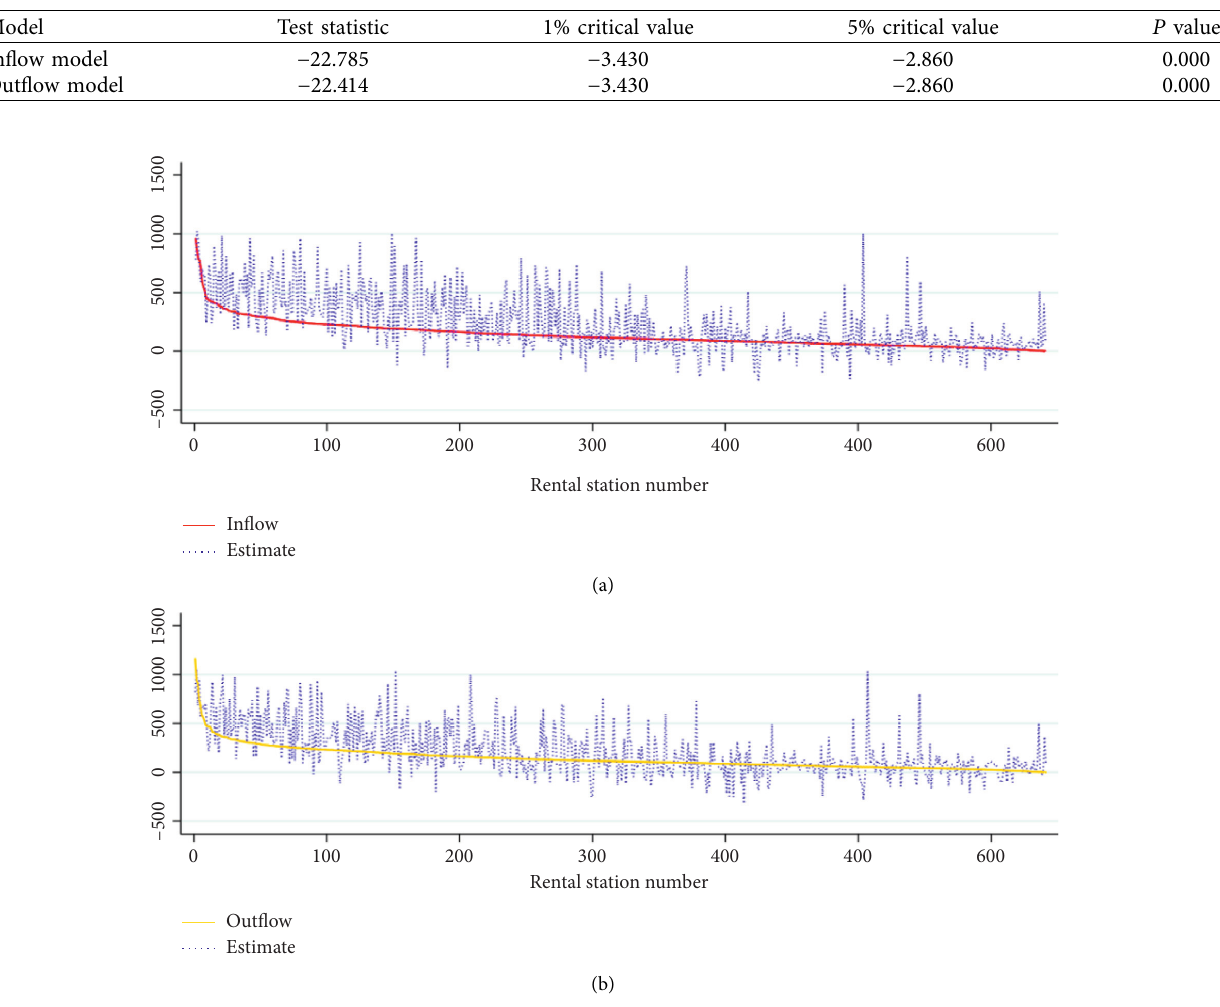
Figure 6: Comparison between estimated value of the model and real value. Table 8: Parameters and coefficients’ estimated values in inflow